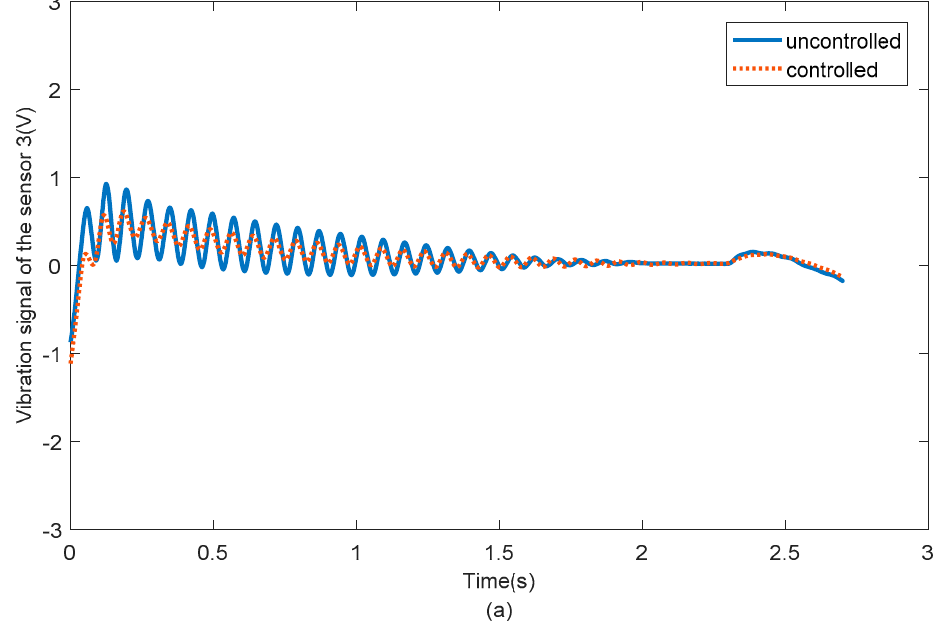
Figure 18. The vibration signals of passive flexible link 3 for the uncontrolled and controlled systems.